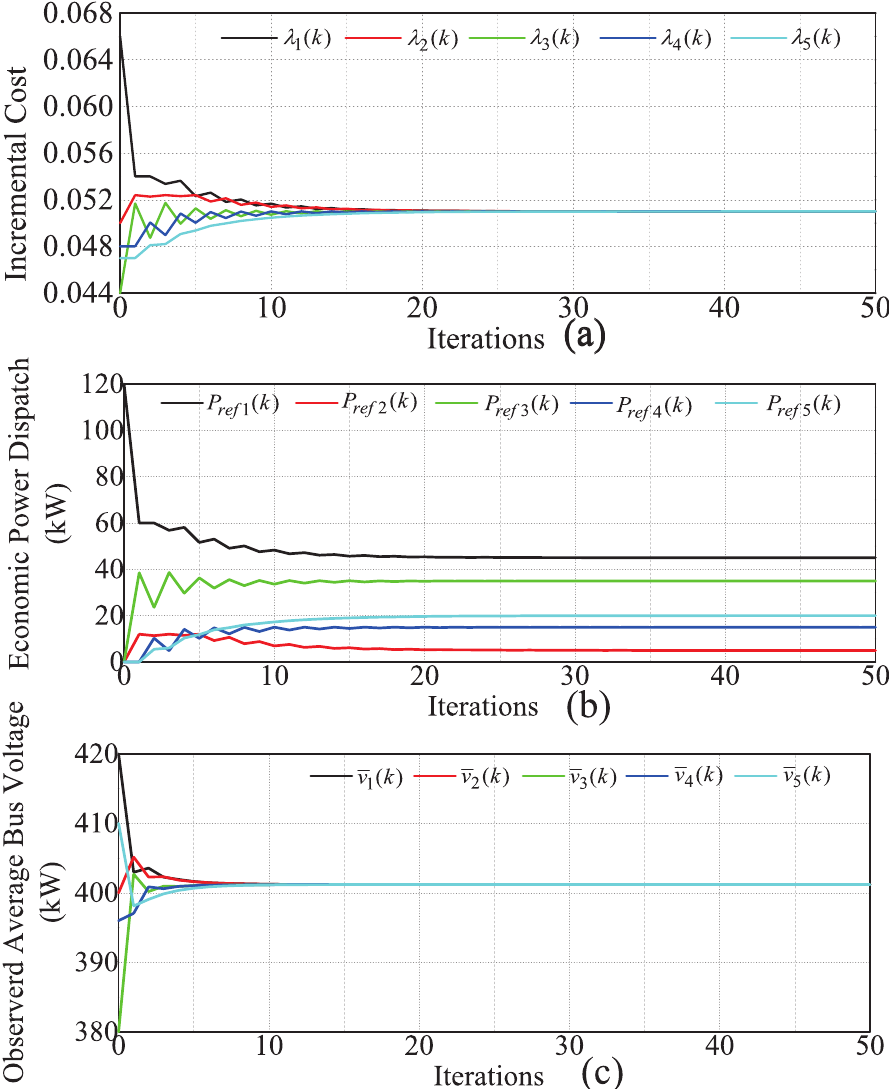
Figure 6. Convergence test of the EPD and ABVO algorithms for a DC microgrid with 5 DGs. ( a ) Incremental cost of the DGs in each iteration; ( b ) EPD of the DGs in each iteration; ( c ) observed average bus voltage of the DGs in each